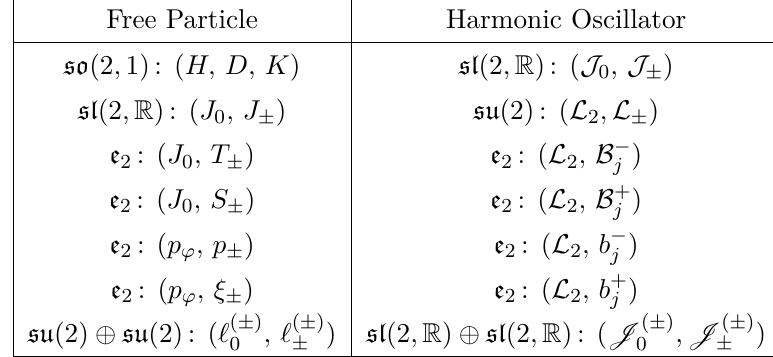
Table 1. Correspondence between some subalgebras and their